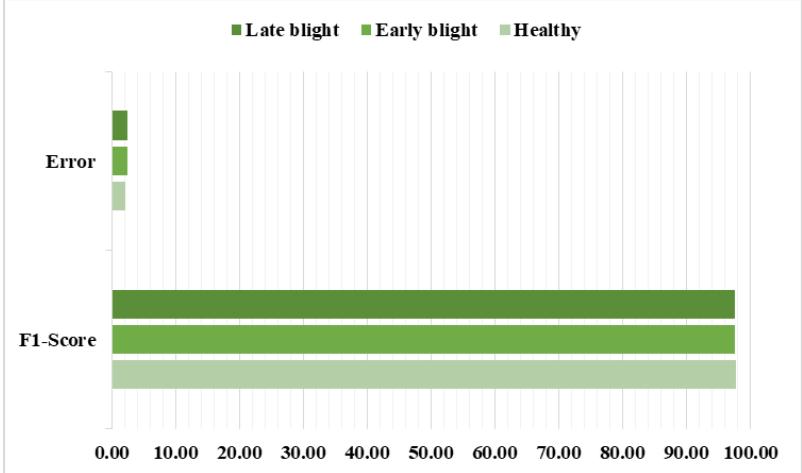
error scores are 2.46%, and 2.17%, for the late blight and healthy classes of potato plant leaves, respectively.